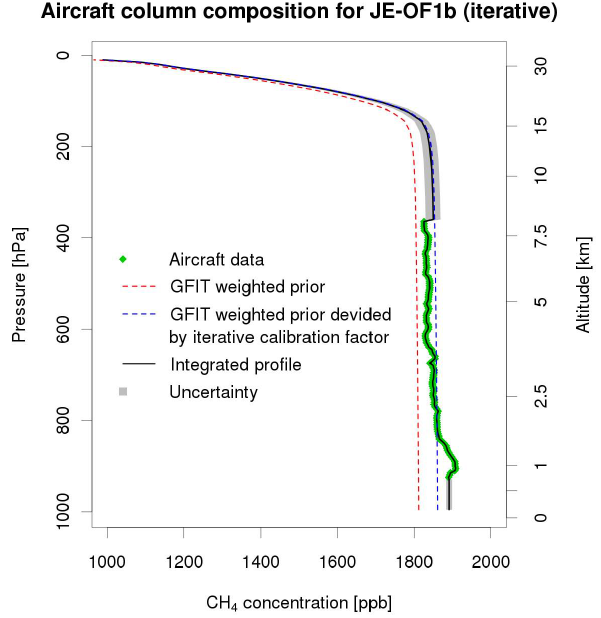
Fig. 10. Example for the extension of aircraft data to a total col- umn (JE-OF1b) using an a-priori profile scaled with an iteratively- derived calibration factor (blue line). The other colored lines are the same as in Fig.